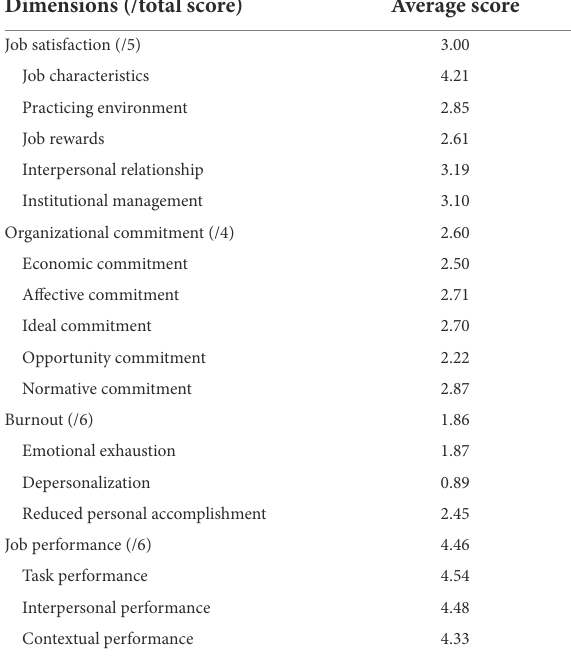
TABLE 4 Predicting factors of self-reported job